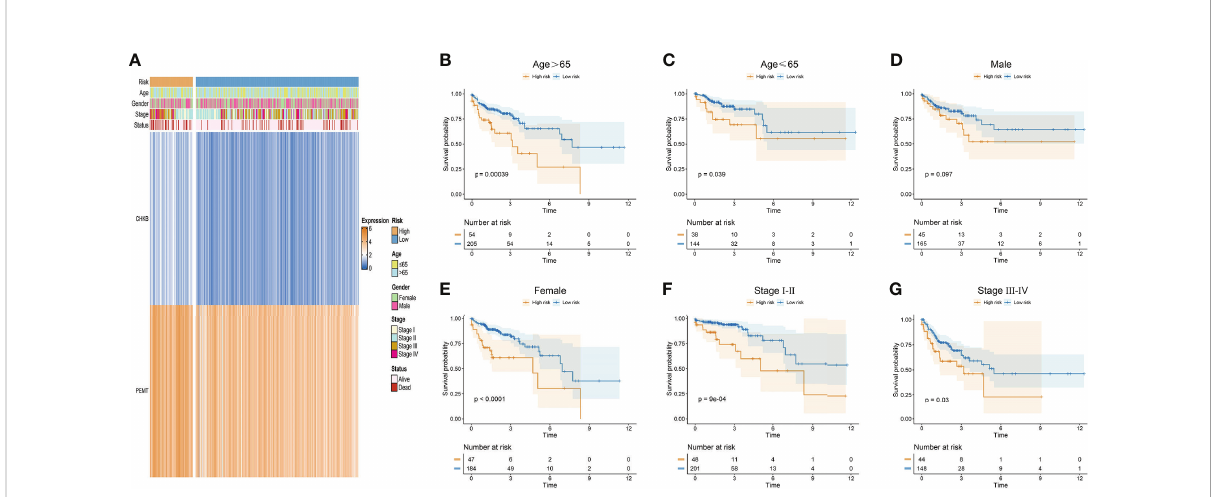
FIGURE 5 Relationship of the choline metabolism-related signature with clinicopathological manifestations. (A) Correlation of choline metabolism-related genes with clinicopathological manifestations. (B – G) KM survival curves of patients in the high- and low-risk groups strati fi ed by age (B, C) , gender (D, E) , and stage (F, G) .